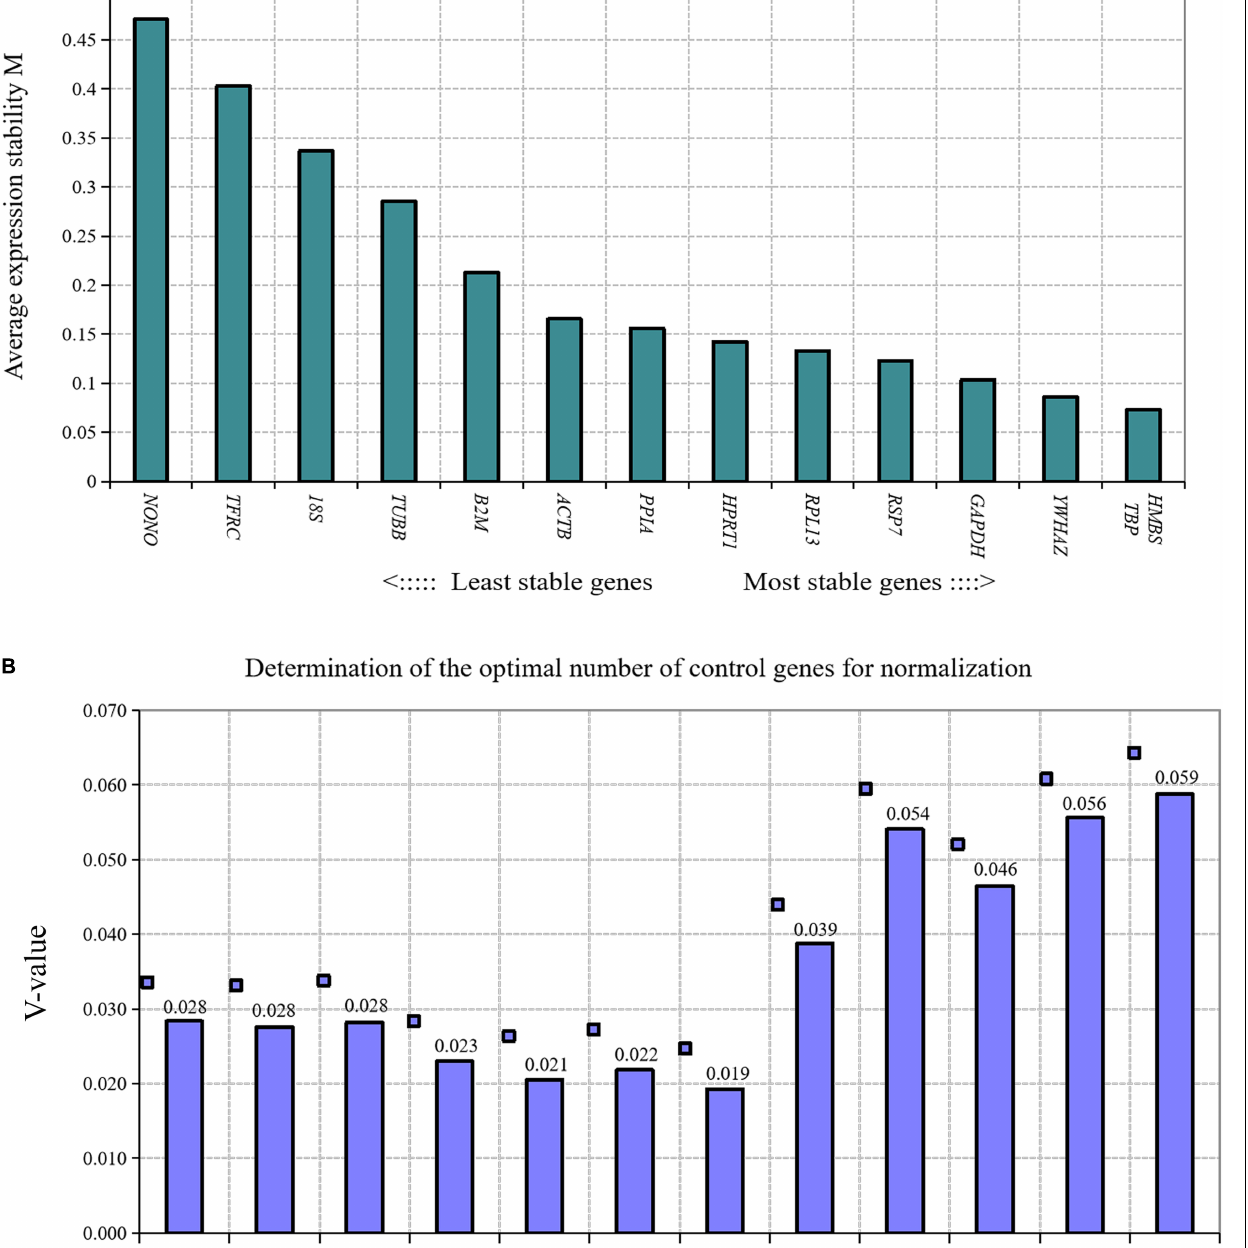
Frontiers in Physiology |